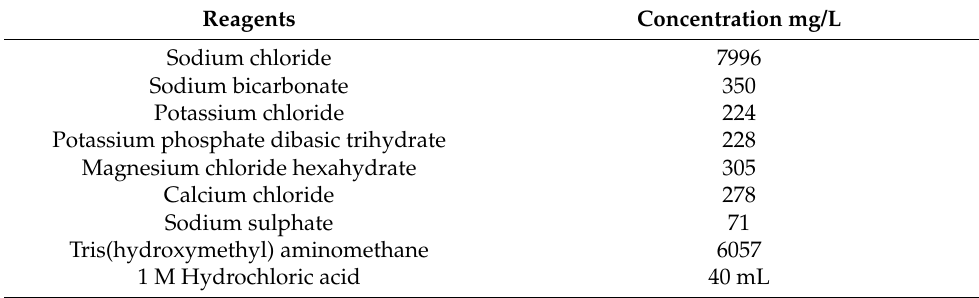
Table 3. Quantities used to prepare 1000 mL conventional simulated body fluid (c-SBF) adapted from [30], Elsevier,